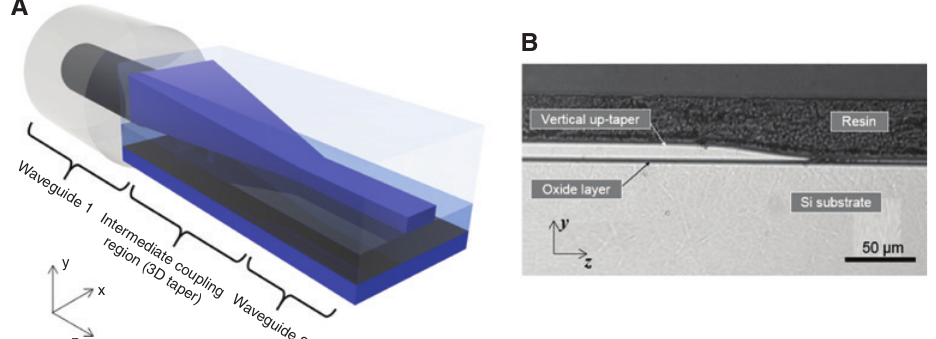
Figure 3: (A) Schematic diagram of a three-dimensionally tapered intermediate waveguide structure. (B) An example of a vertically tapered waveguide fabricated by gray-tone shadow